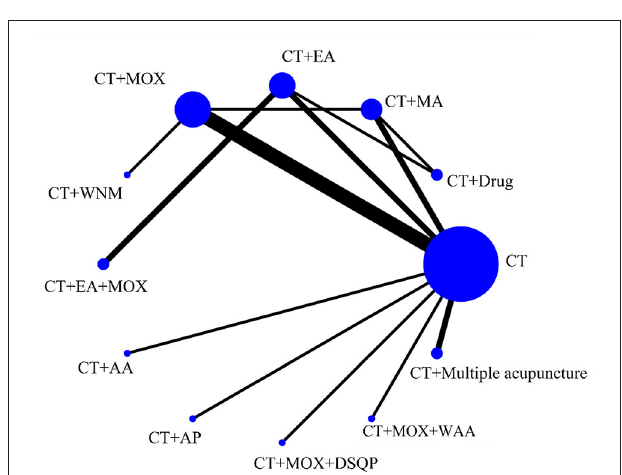
FIGURE 3 | Network of eligible comparisons for the network meta-analysis of CER. Each node represents an intervention and the size of each node represents the number of randomly assigned participants. Each line represents a direct comparison between interventions and the width of the lines represents the number of